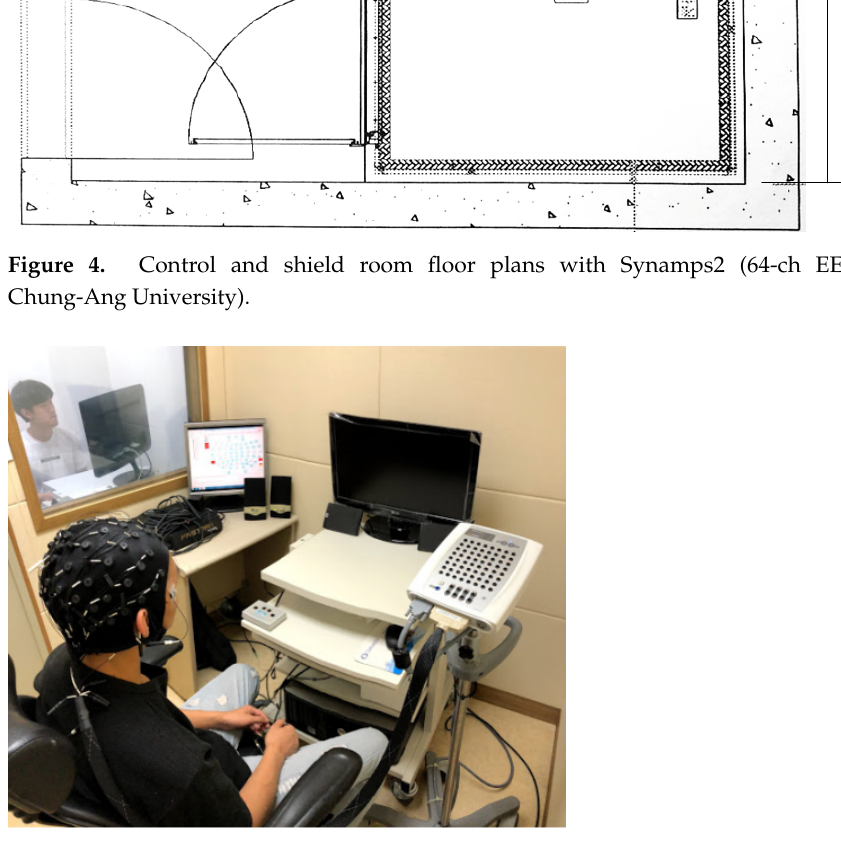
Figure 5. EEG measurement in the shielded room in the Ubiquitous Robot and Intelligent Information System (URIS) Laboratory, Chung-Ang